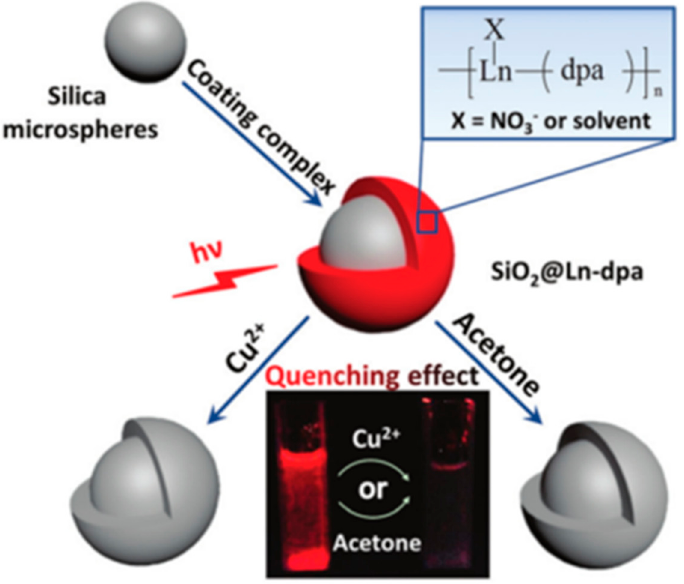
Figure 12. Schematic of synthesis and sensing process of SiO 2 @Ln-dpa core–shell microspheres. Reproduced from [77], with permission from the Royal Society of Chemistry, 2016.